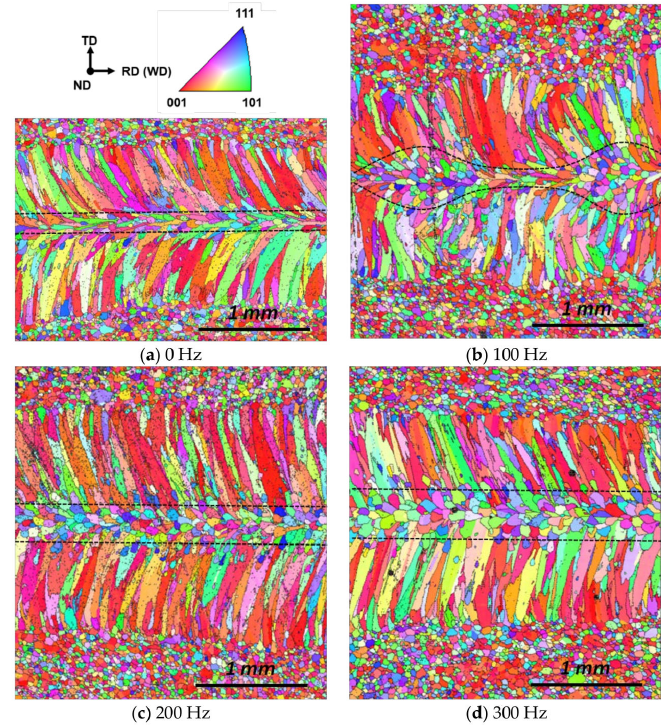
Figure 10. EBSD analysis with varying oscillation frequencies. Welding was performed with infinite-shaped beam pattern under 900 W laser power at 3.5 m/min welding speed. The oscillation width was fixed at 0.8 mm, while the frequency was varied at ( a ) 0 Hz; ( b ) 100 Hz; ( c ) 200 Hz and ( d ) 300